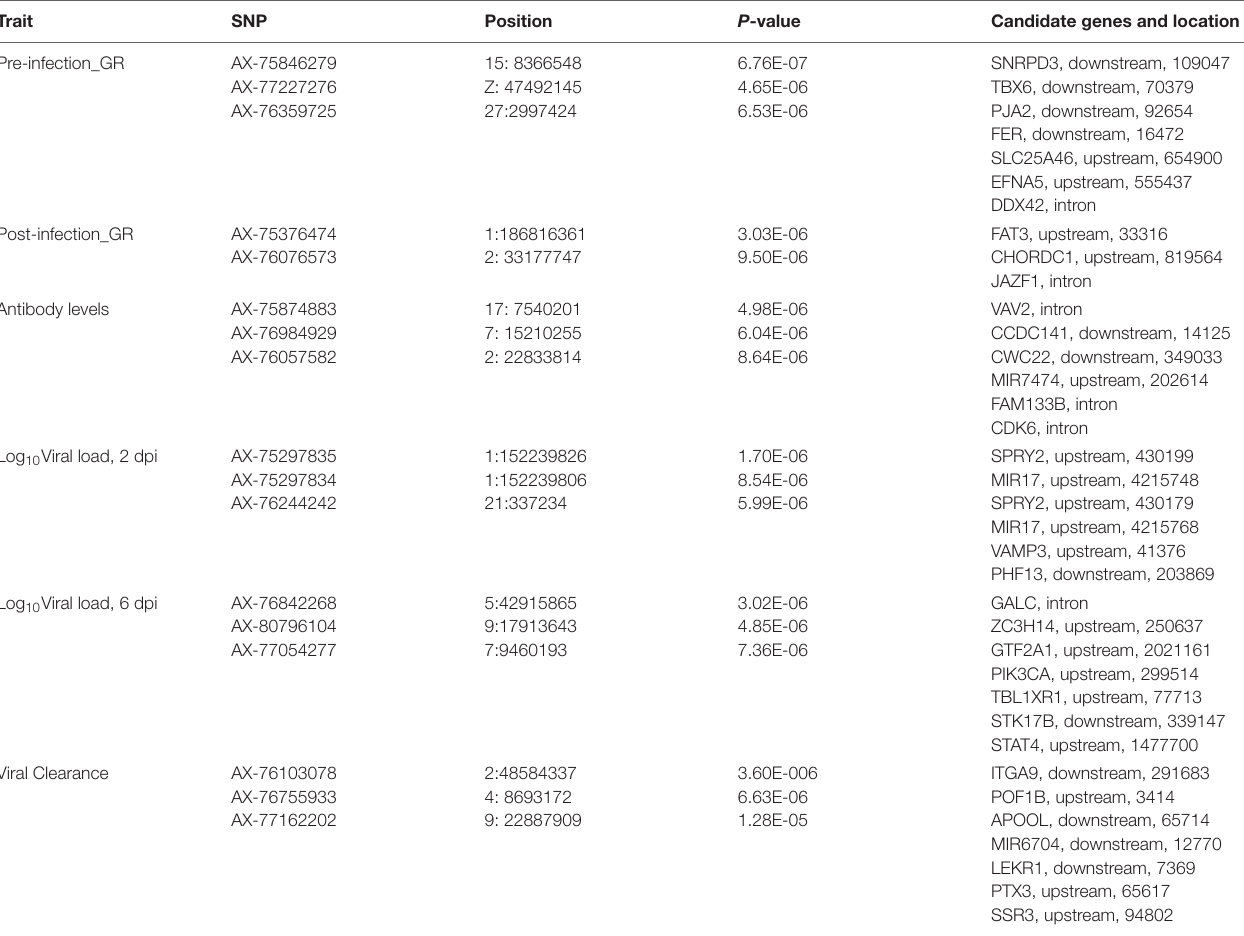
TABLE 5 | Single nucleotide polymorphisms (SNPs) associated with NDV response traits in the Ghana local chicken ecotypes population, along with positional candidate genes and previously reported QTL. Trait SNP Position P -value Candidate genes and